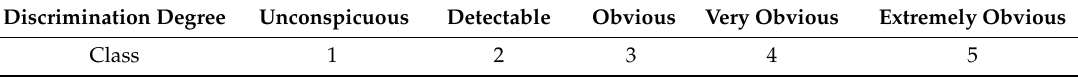
Table 4. Directional discrimination degree class.